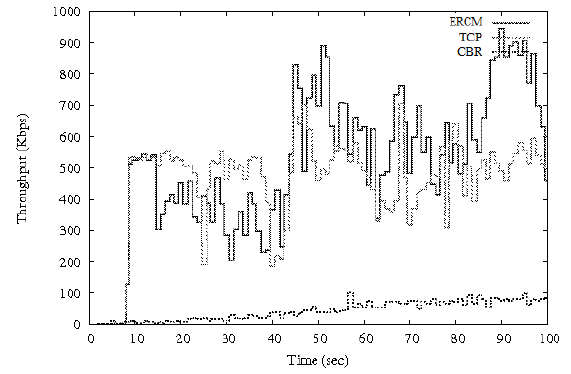
Fig. 4. Instantaneous throughput comparisons of ERCM, TCP and UDP